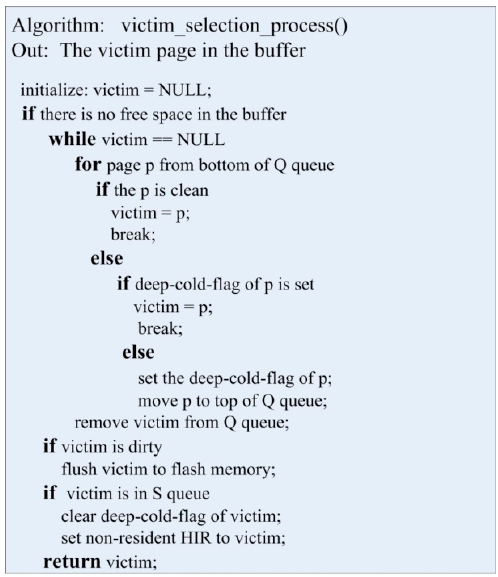
Figure 4. The pseudo-codes of the victim selection policy of PA-LIRS. Electronics 2020 , 9 , x FOR PEER REVIEW